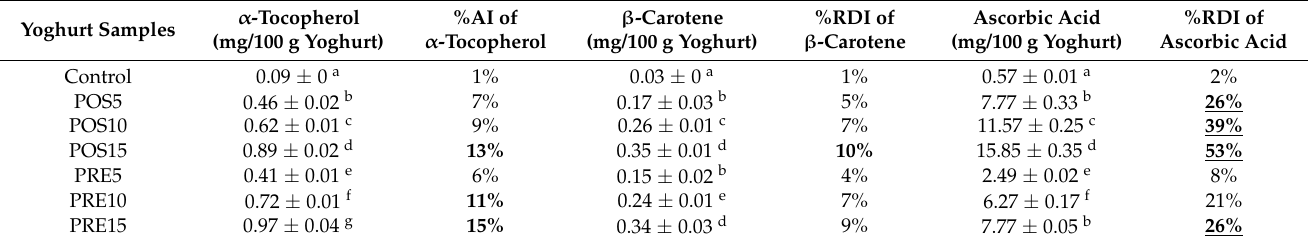
Table 4. Concentrations and % RDI/AI of α -tocopherol, β -carotene, and ascorbic acid in yoghurt